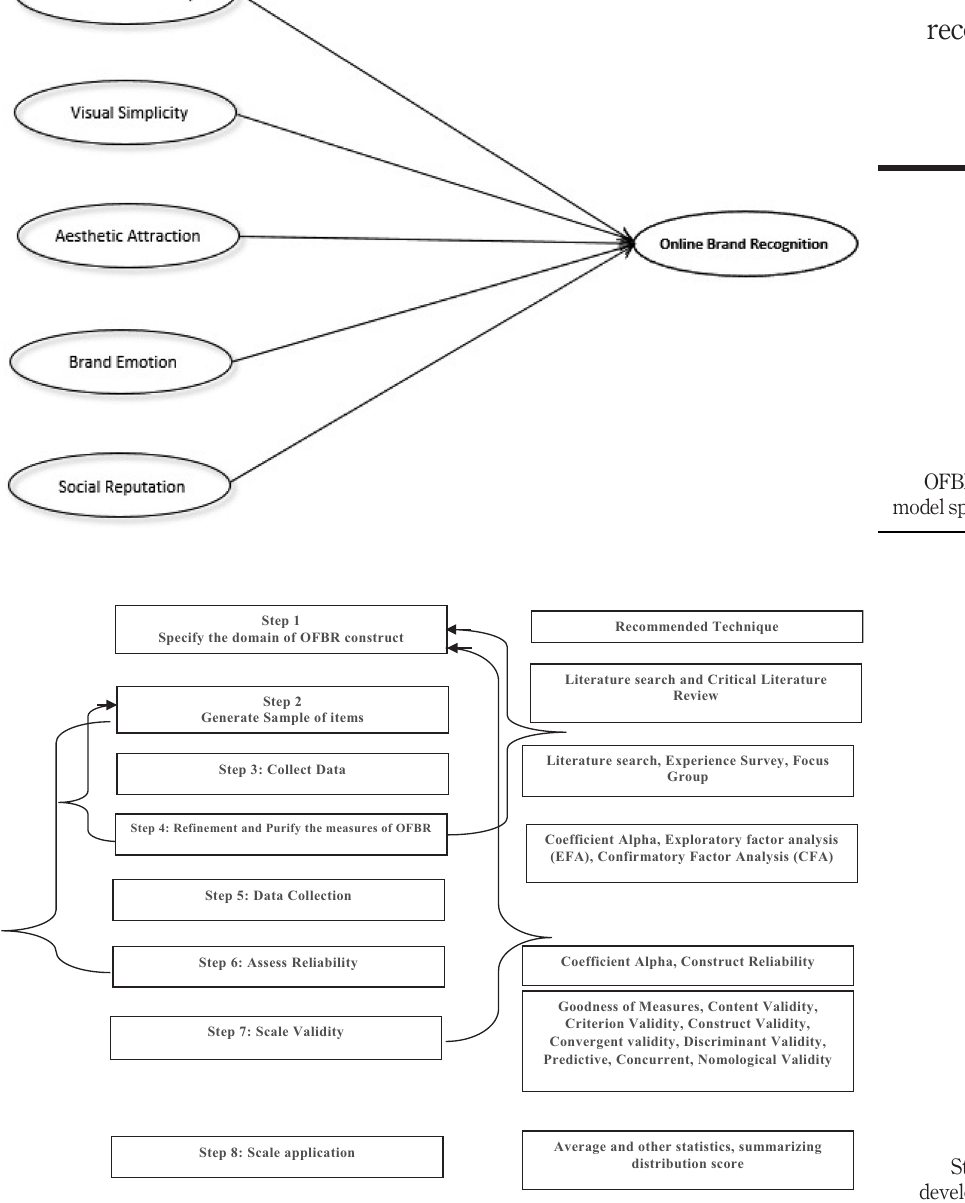
Figure 2. Steps of